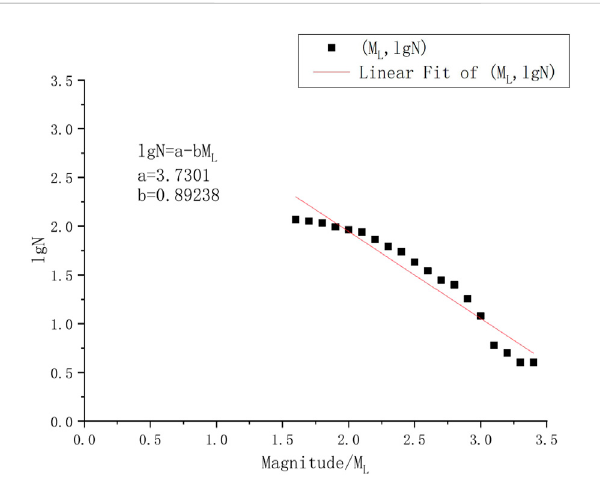
FIGURE 2 Fitting diagram of seismic b value in the research